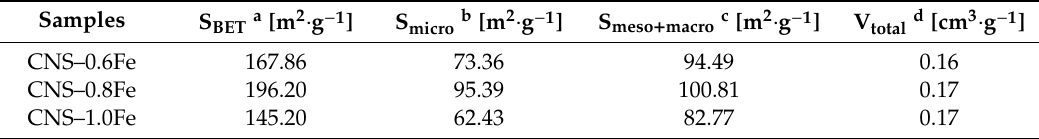
Table 1. Surface area, porosity of CNSs.